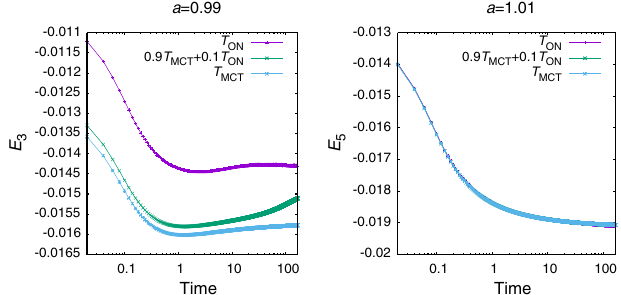
FIG. 15. Four-spin model slightly perturbed with three-spin terms ( a ¼ 0 . 99 , left panel) and with five-spin terms ( a ¼ 1 . 01 , right panel). The time evolution of the perturbing term energy makes evident the different dynamical behavior: For a ¼ 0 . 99 , FIG. 14. Approximate phase diagram for the mixed model we see the effects of the onset of glassy dynamics, which are not defined in the text, interpolating between pure p -spin models visible for a ¼ 1 . 01 , thus supporting the singular T with p ¼ 3 þ a when a is an integer. The three different regimes are delimited by T (orange dashed line) and T (blue solid onset SF line). In addition, we plot the mode-coupling temperature T MCT (red solid line). Note that T is shown with a dashed line to onset stress the fact that it is the result of an approximation. Notice its discontinuous behavior around the pure models.